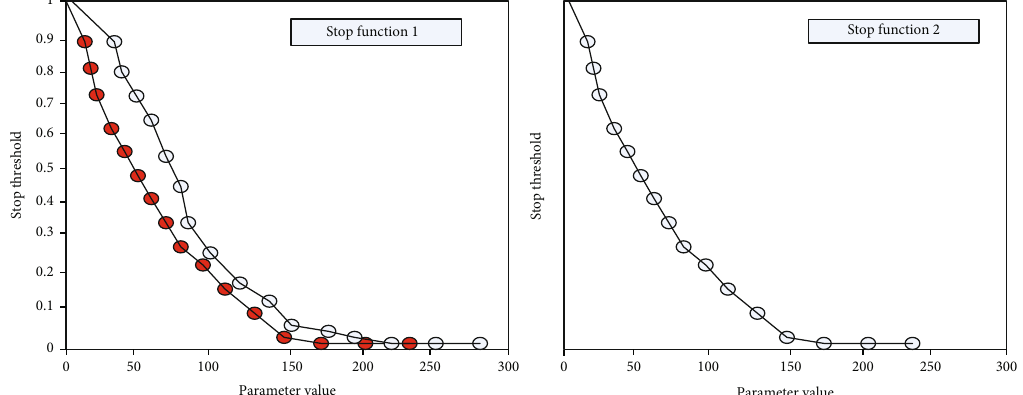
Figure 4: Behavior diagram of the stop function of the improved partial di ff erential equation video recognition ffiffiffiffiffiffiffiffiffiffiffiffiffiffiffiffiffiffiffiffiffiffiffiffiffi